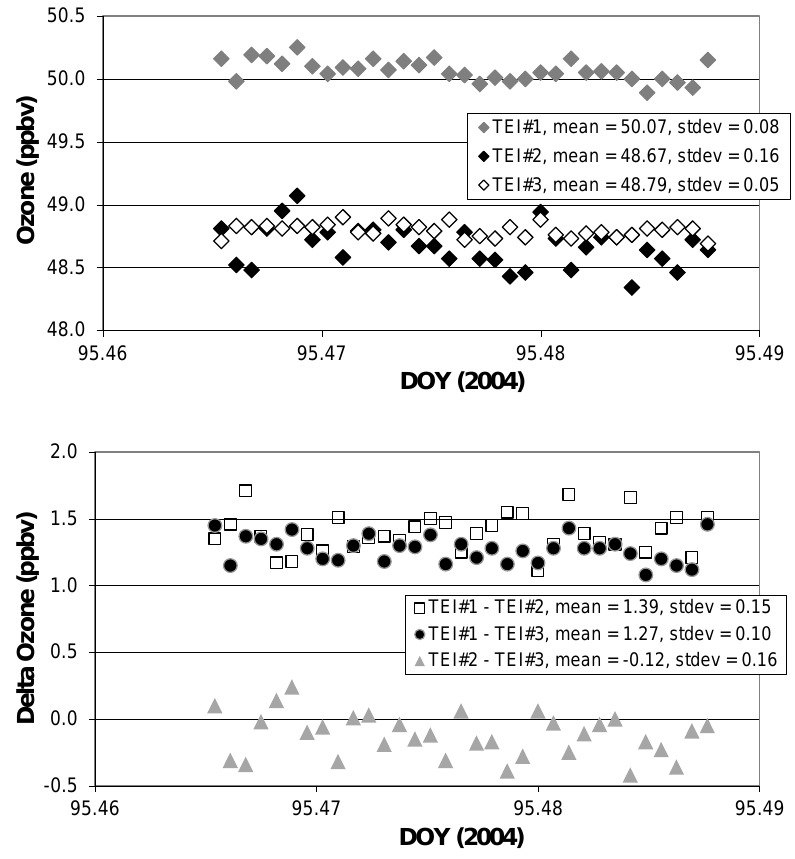
Fig. 3. Example of ozone monitor inter-comparison data set, where inlets from all three monitors were kept at the same height for determina- tion of the instrument offset and precision of the gradient measurement. The upper graph shows the actual measurement from each monitor. The bottom graph shows the calculated “gradient” during the same